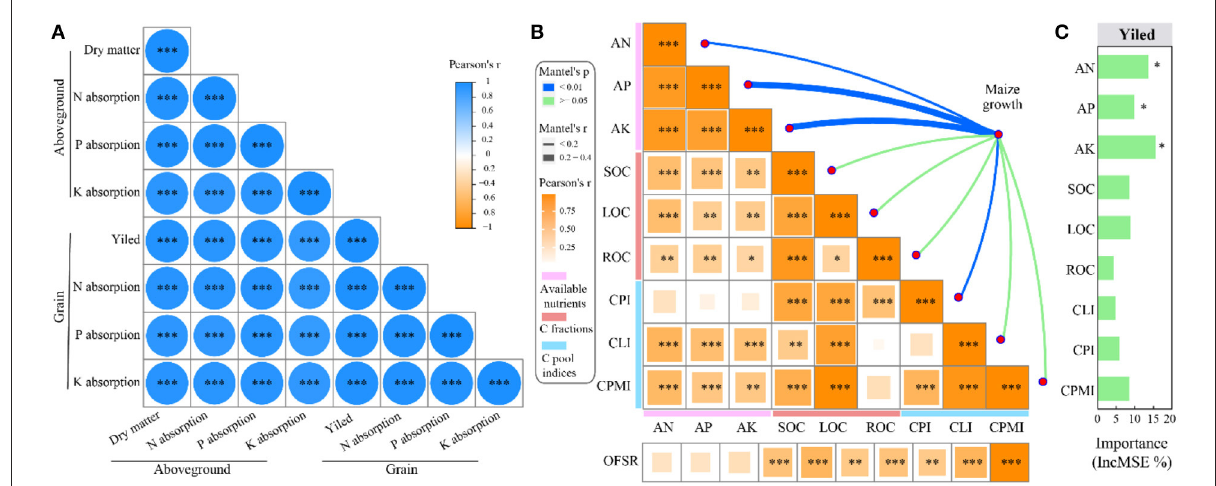
FIGURE3 Correlation analysis (A) and Mantel analysis (B) of maize growth characteristics (total dry matter, N, P, and K absorption of maize aboveground) and soil properties ( n = 45). Random forest analysis predicts the key soil factors affecting yield (C) . *, **, and *** represent significant differences at the level of p < 0.05, p < 0.01, and p < 0.001, respectively. Soil available nutrients include available nitrogen (AN), available phosphorus (AP), and soil available potassium (AK). C fractions include soil organic carbon (SOC), recalcitrant organic carbon (ROC), and labile organic